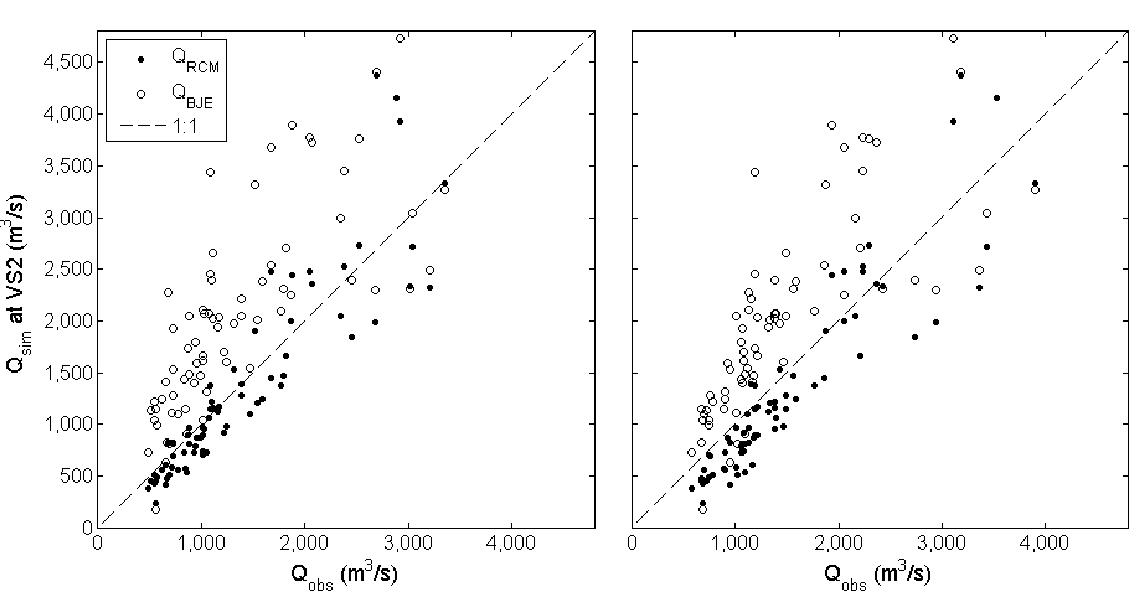
Figure 4. Piacenza-VS2 river reach: comparison between the discharge simulated by using the Rating Curve Model (RCM) and the Bjerklie formula and the observed in situ discharge for the two gauged station of Sermide ( left ) and Pontelagoscuro ( right ).